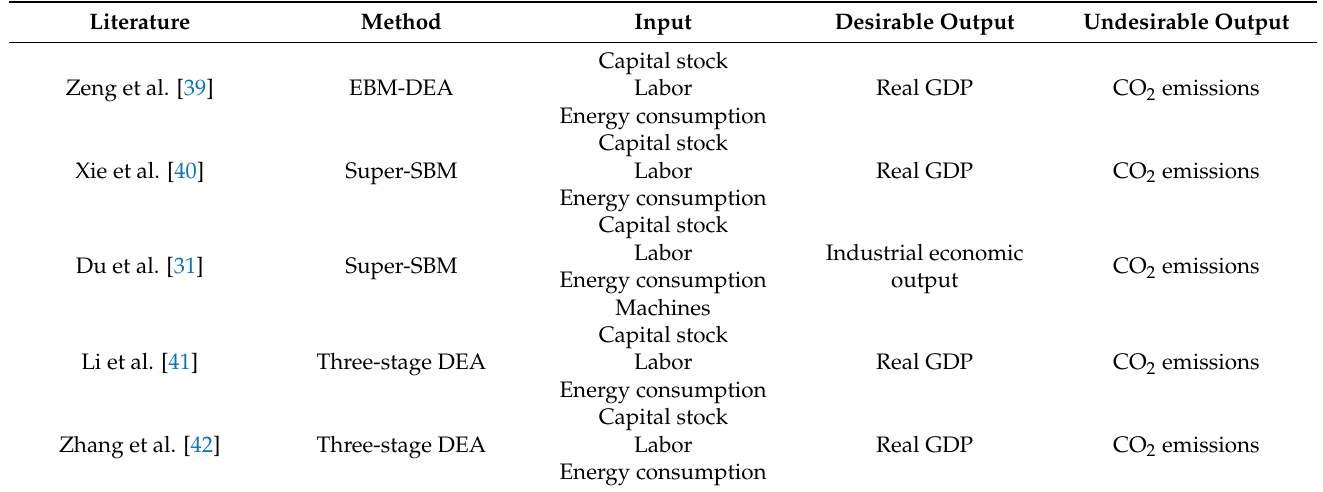
Table 1. Studies measuring carbon emission